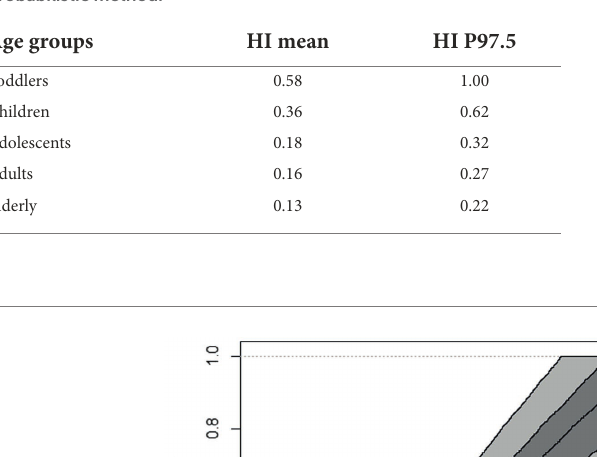
TABLE 2 Mean and 97.5th percentile (P97.5) hazard index (HI) values of the different age groups for 2019–2022, calculated with a probabilistic